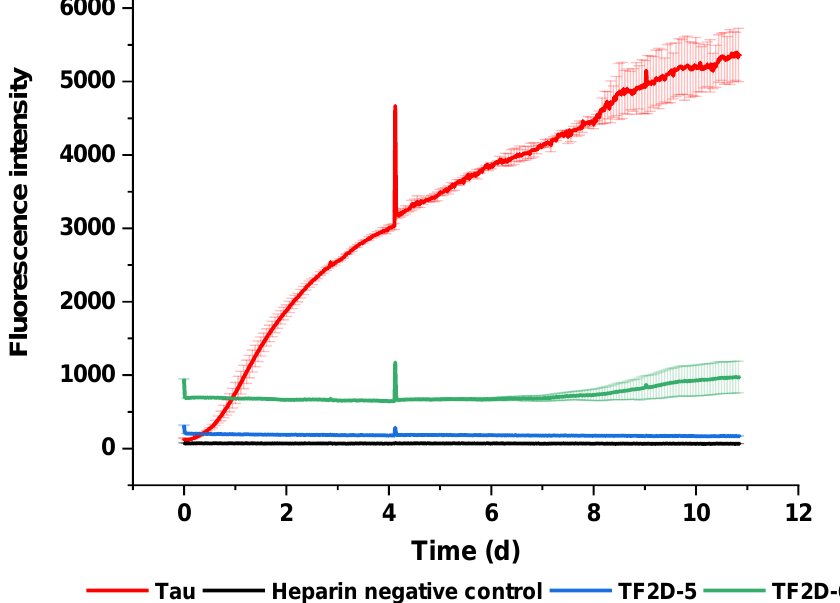
Figure 3. Screening for aggregation-inhibiting compounds via ThT assay. Each of the initial ten compounds was tested in a ThT screening to check if they had an aggregation-modifying effect on full-length tau 441. All compounds were mixed in a concentration of 50 µ M with 50 µ M recombinant full-length tau 441, 12.5 µ M heparin, 500 µ M DTT, 2% DMSO, and 20 mM ThT. Every well was adjusted to 100 µ L with 1 × PBS pH 7.4. Measurements were taken in intervals of 20 min. The plate was incubated at 37 ◦ C and shaken for 15 s at 300 rpm before each measurement. The tau control did not contain any compounds, while the heparin negative control lacked both heparin and compounds. We chose 50 µ M tau to allow de novo aggregation of tau to happen within days. We are fully aware that this is not a physiological concentration of tau. At about four days incubation time, measurement was prematurely terminated. Data recording was restarted without any time delay. The initial measurement points contained artefact signals that led to the spikes observed at about 4 days incubation.